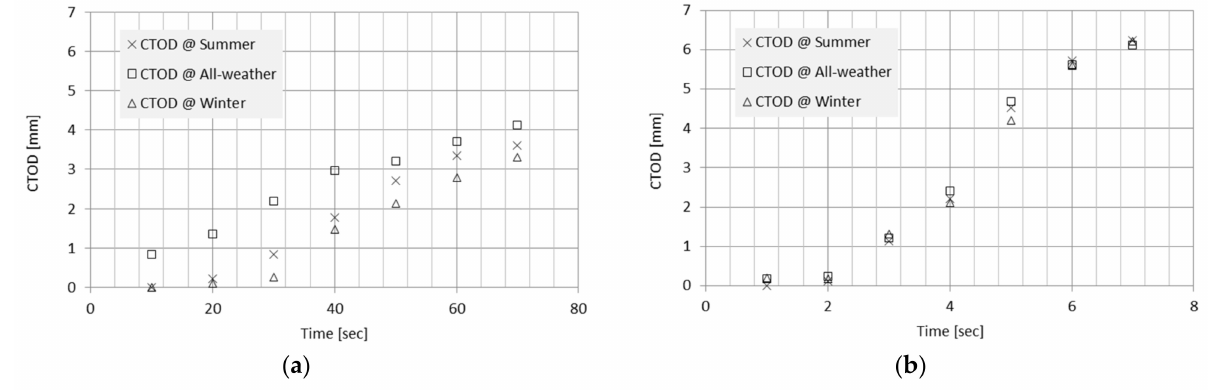
Figure 9. CTOD(Y)–time(X) curves: ( a ) CTOD(Y)–time(X) curves at 5 mm/min; ( b ) CTOD(Y)–time(X) curves at 50